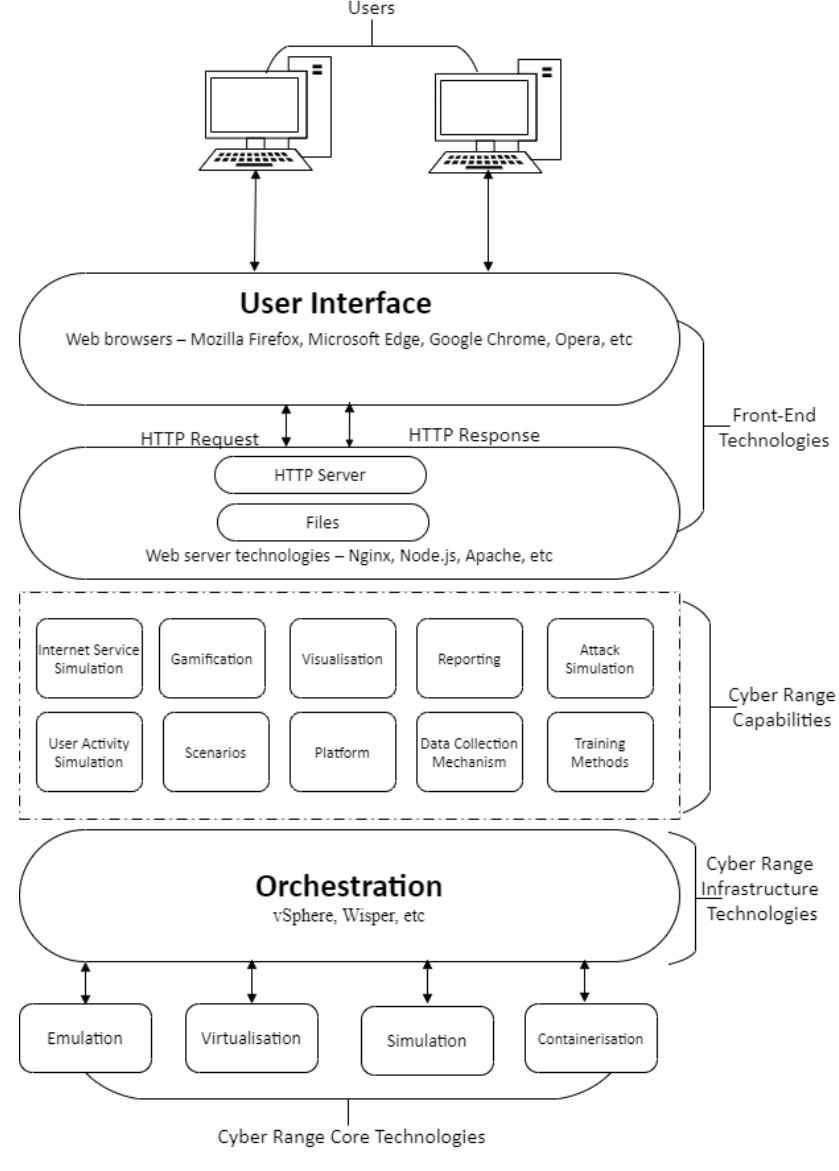
Figure 8. Architectural Design of a